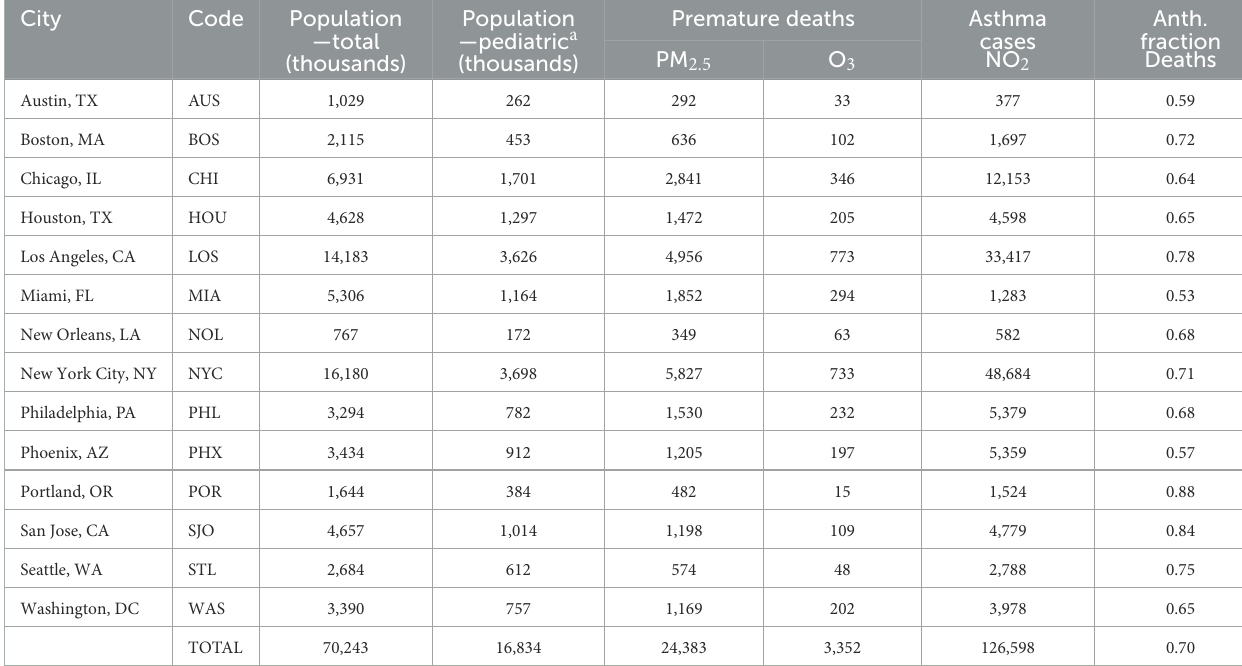
TABLE 2 Population, under 20 years old population, PM 2.5 - and O 3 -related premature deaths, NO 2 -related asthma cases, and the anthropogenic component of PM 2.5 - and O 3 -related premature deaths for each of the study cities.